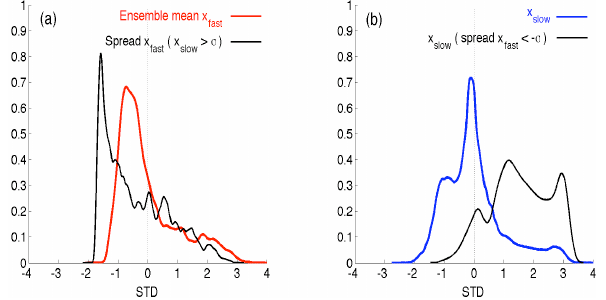
Fig. 5. Spread of x a ensemble members with no offset forcing ( k 1 = k 2 =